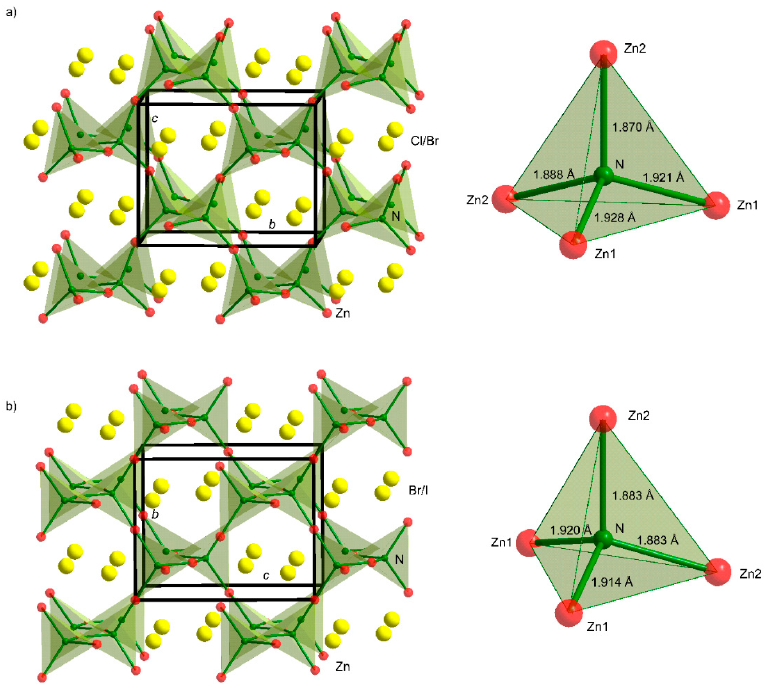
Figure 1. Polyhedral representation of [NZn 4 ] tetrahedra and the local nitrogen coordination in Zn 2 NCl 0.47 Br 0.53 ( a ) and Zn 2 NBr 0.62 I 0.38 ( b ). The Cl/Br and the Br/I anions statistically occupy the tetrahedral voids in the